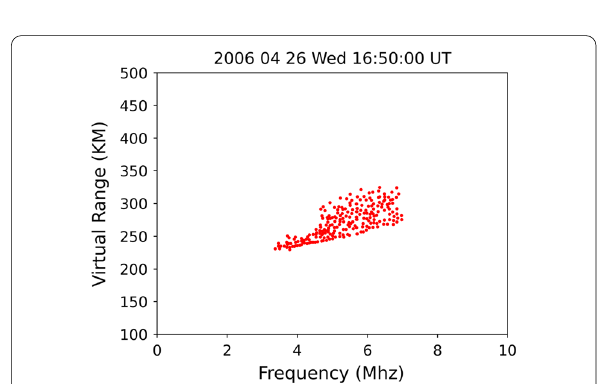
Fig. 8 The ionogram from the Chung‑li dynaosnde 2006/4/26 16:45:00UT. The Range Spread F event occurred at the same time. The height of the Spread F is between 250 and 300